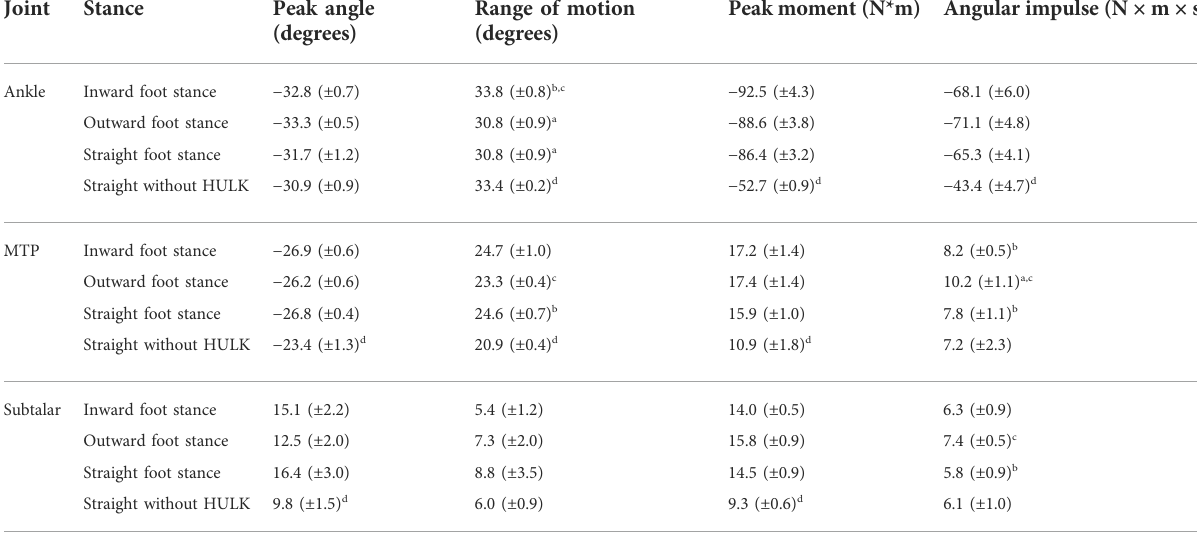
TABLE A1 Average (±SD) peak angle, range of motion, peak moment, and angular impulse during heel raises for inward foot stance, outward foot stance, straight foot stance, and straight stance without HULK conditions. Joint Stance Peak angle Range of motion Peak moment (N*m) Angular impulse (N × m × s) (degrees) (degrees) Inward foot